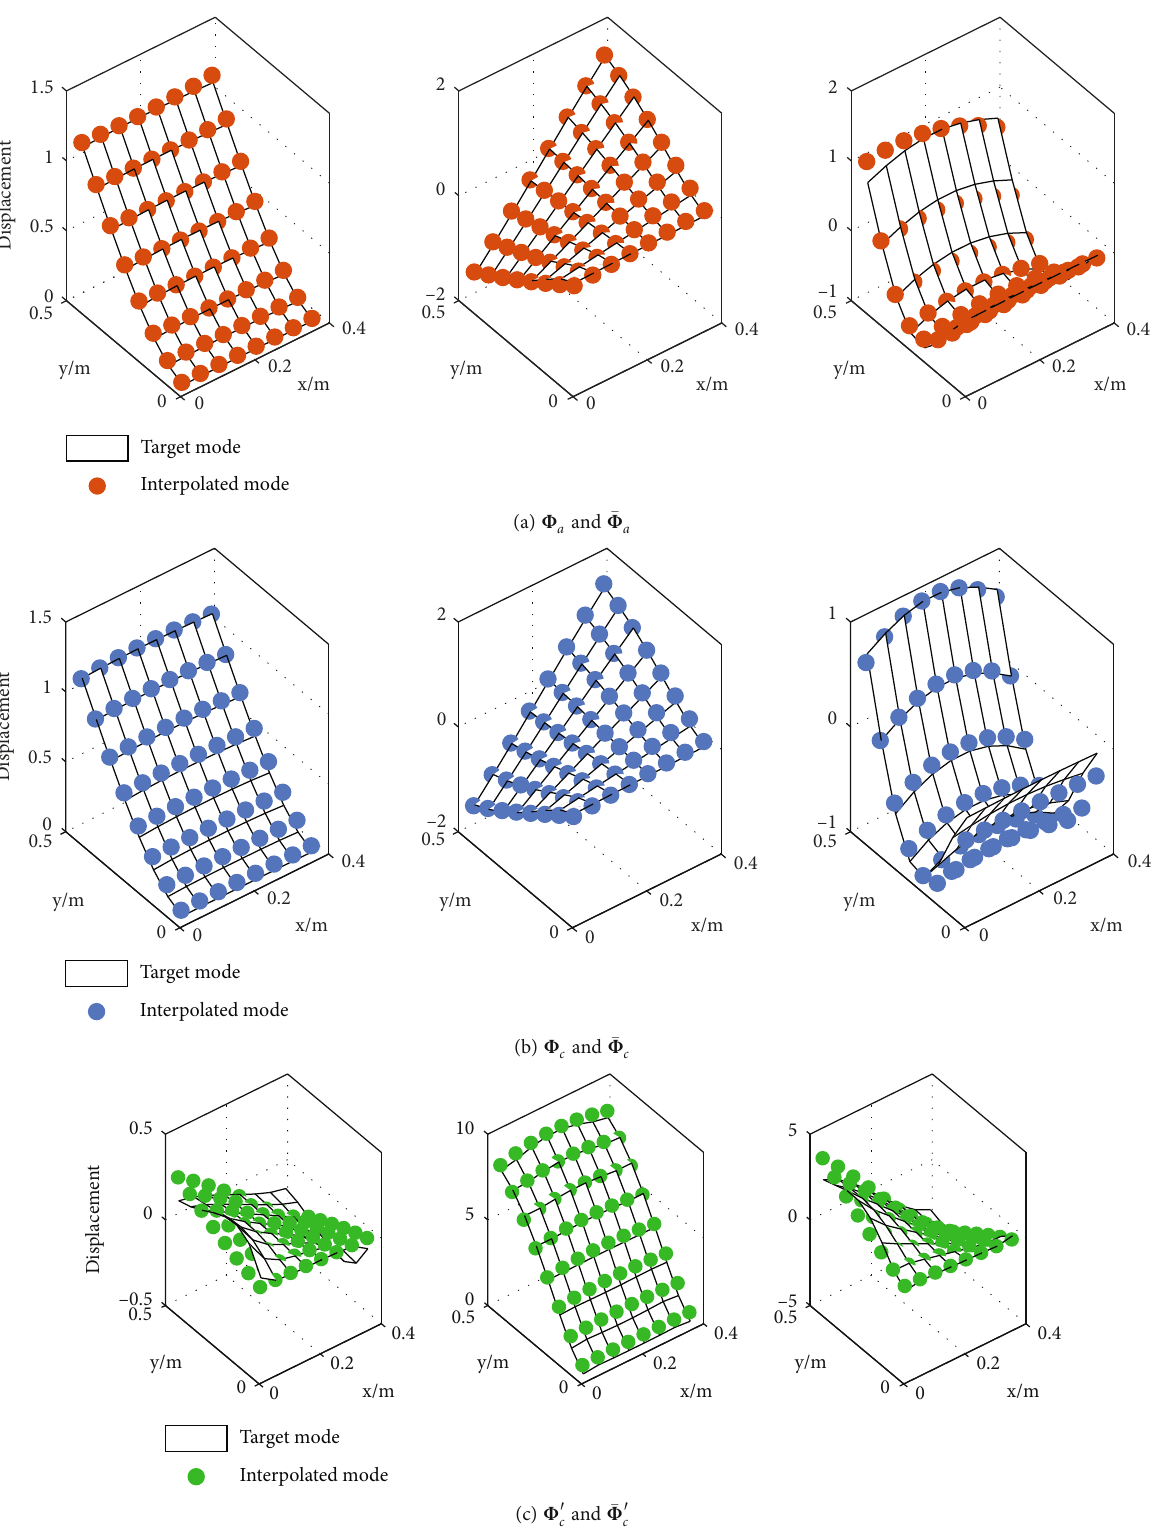
Figure 9: Comparison of the three lowest-order mode shapes and mode